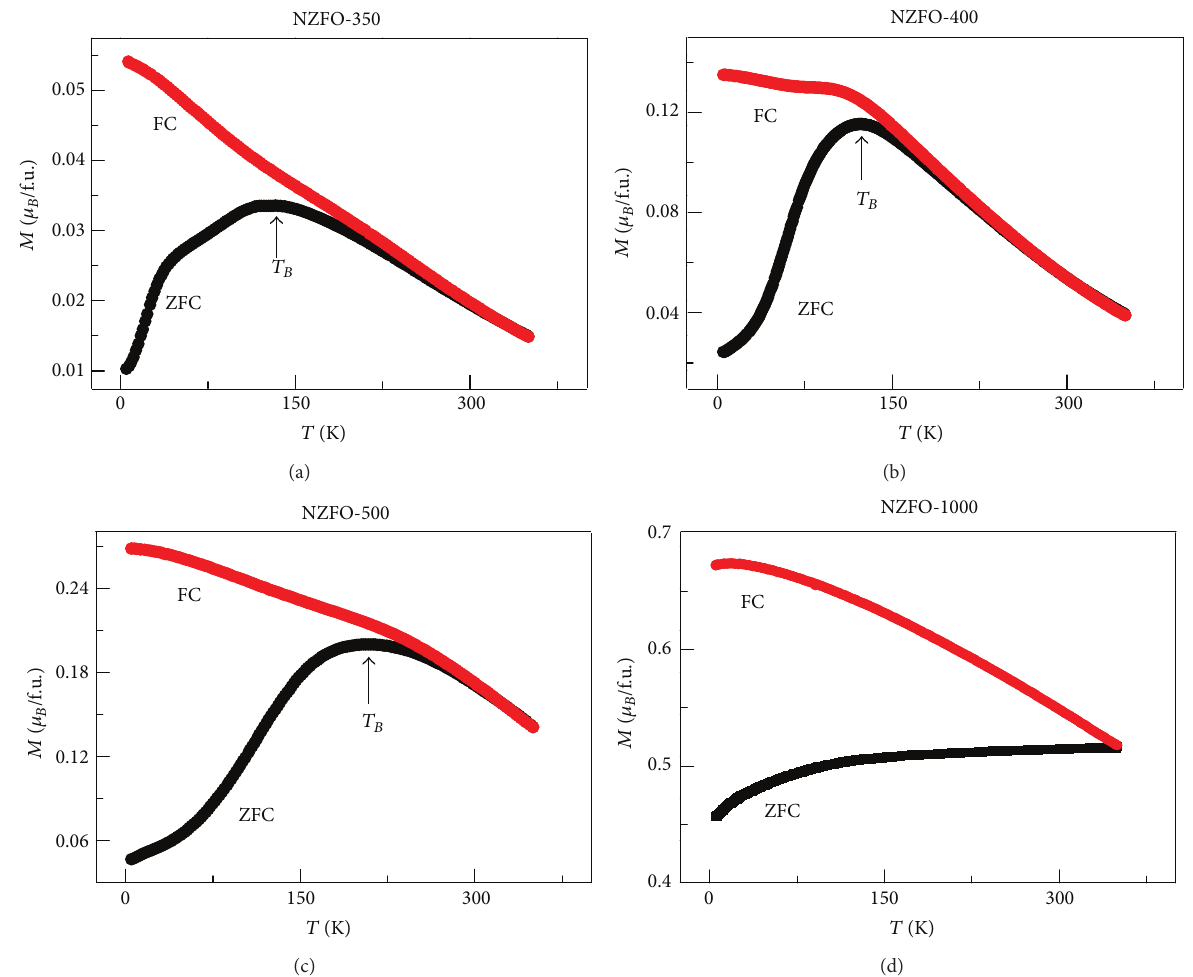
Figure 8: Temperature dependence of magnetization for field cooled (FC) and zero-field cooled (ZFC) Ni 0.5 Zn 0.5 Fe 2 O 4 nanoparticles at applied field of